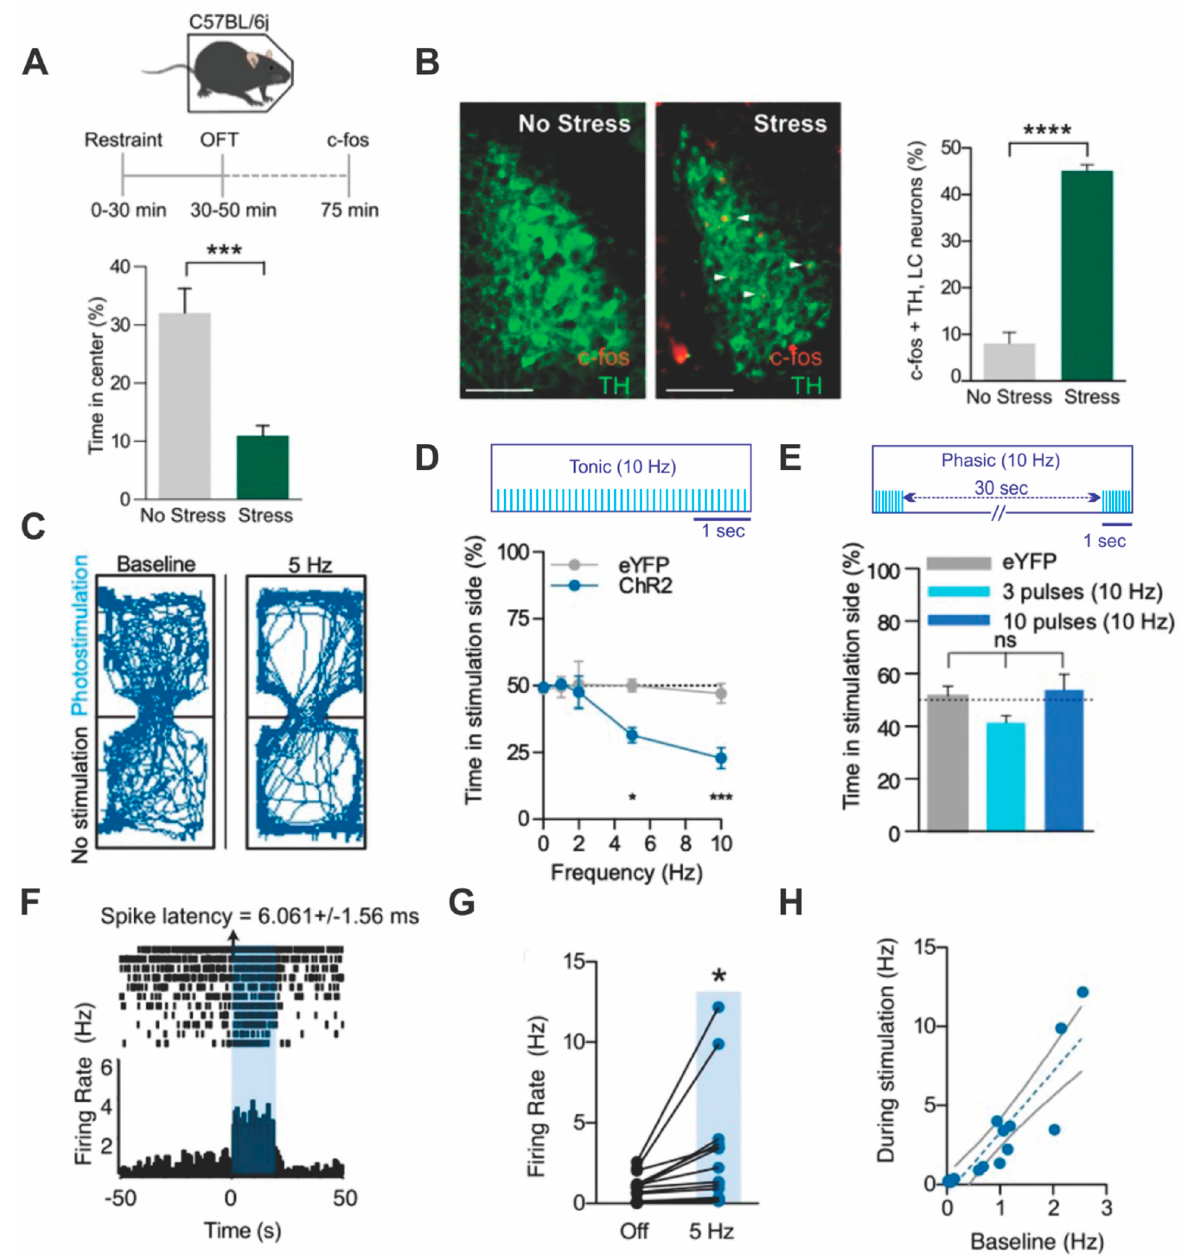
Figure 3. Tonic LC optogenetic stimulation induces anxiety and aversion despite heterogeneous LC cell firing. ( A ) Restraint stress was given to C57bl/j6 mice for 20 min before a 10 min open field test (OFT). Stressed mice spent less time in the center. ( B ) Locus coeruleus (LC) c-fos was examined in both no stress and stress groups. Red c-fos cells are among green tyrosine hydroxylase-reactive (TH) cells in a stressed mouse in the right image. Stress-induced LC c-fos activation of ~45% is quantified in the adjacent graph. ( C ) An illustration of place avoidance during a 20 min test with LC activation at 5 Hz when in the photo-stimulated chamber. Note center avoidance in both chambers. ( D ) The 10 Hz tonic pattern cartoon. Time in photo-stimulated side across tonic frequencies. Further, the 5–10 Hz tonic activations produce avoidance. ( E ) The 10 Hz 10 pulse phasic pattern cartoon. The 10 Hz phasic patterns do not produce avoidance in the same 20 min test. ( F ) An identified LC neuron histogram with repeated 20 s tonic 5 Hz light pulses indicated in blue. Repeated trials begin at the top of the raster display. Latency to first spike after light averages ~6 ms. Decreased baseline activity with repeated optogenetic activation trials is evident. ( G ) Firing rates at baseline and for light activation for 16 neurons using a 5 Hz 20 s train. Higher firing units were also recruited on repeated photo-stimulations. ( H ) The relation between baseline and light activated firing rates for the 5 Hz 20 s trains (r = +0.89). * p < 0.05; *** p < 0.01 **** p < 0.001. Adapted with permission from [14]